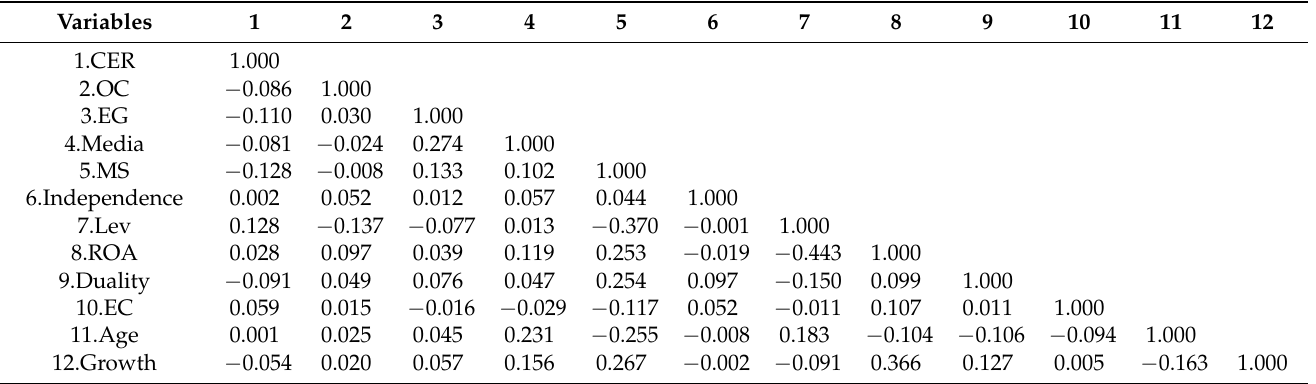
Table 3. The Spearman correlation coefficient between variables.